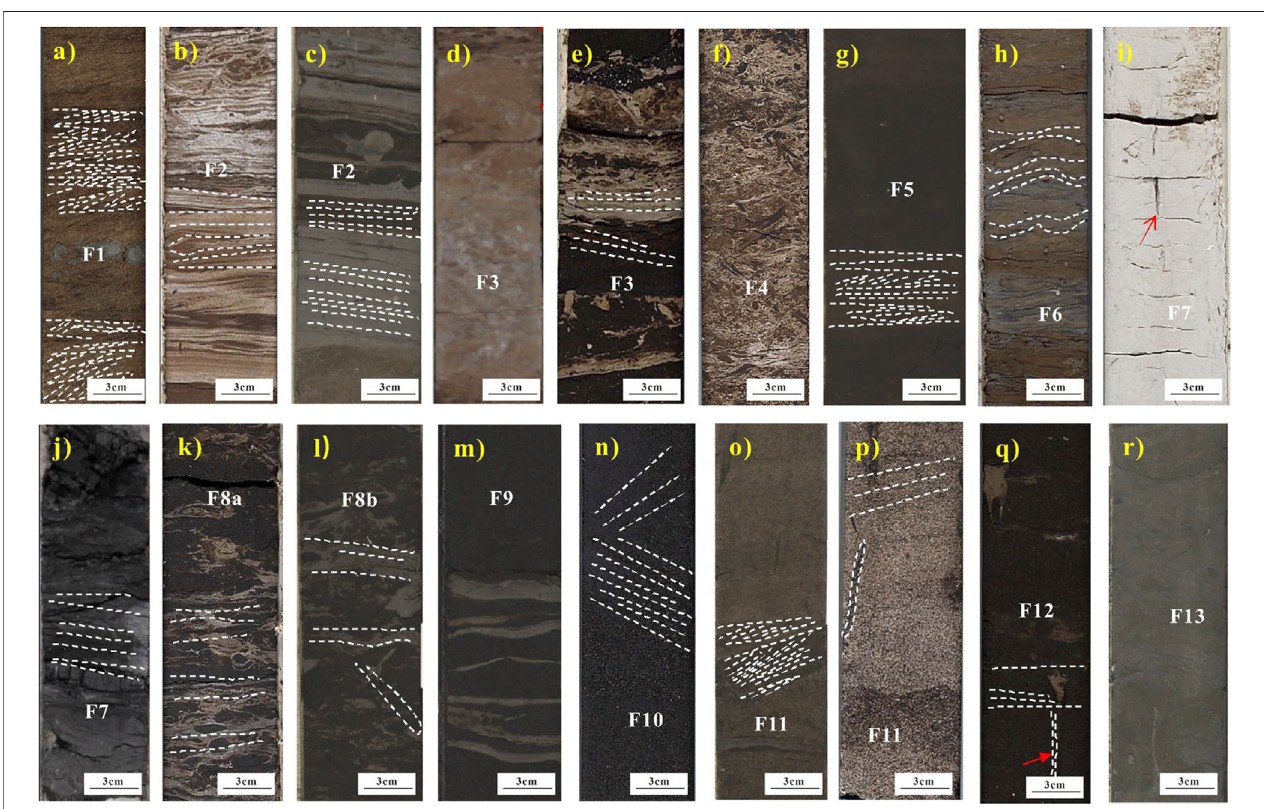
FIGURE 2 | Lithofacies core data of F1-F13. (A) 120,809,114, depth 183.9 m; (B) 101,508,813, depth 181.8 m; (C) 1,030,088,130, depth 184.5 m; (D) 121,209,014, depth 198 m; (E) 122608814, depth 184.6 m; (F) 151908813, depth 192 m; (G) 071908913, depth 211.5 m; (H) 071908913, depth 213 m; (I) 161109014W400,depth201.2 m; (J) 121209014,depth202.7 m; (p) 160109014,depth188.4 m. (K) 160,109,014,depth209.9 m. (L) 103,208,913,depth206.5 m; (M) 071,908,913, depth 199.9 m; (N) 160,109,014, depth 194.2 m; (O) 071,908,913, depth 181 m; (Q) 022,709,014, depth 172.4 m; (R) 071,908,913, depth 193.7